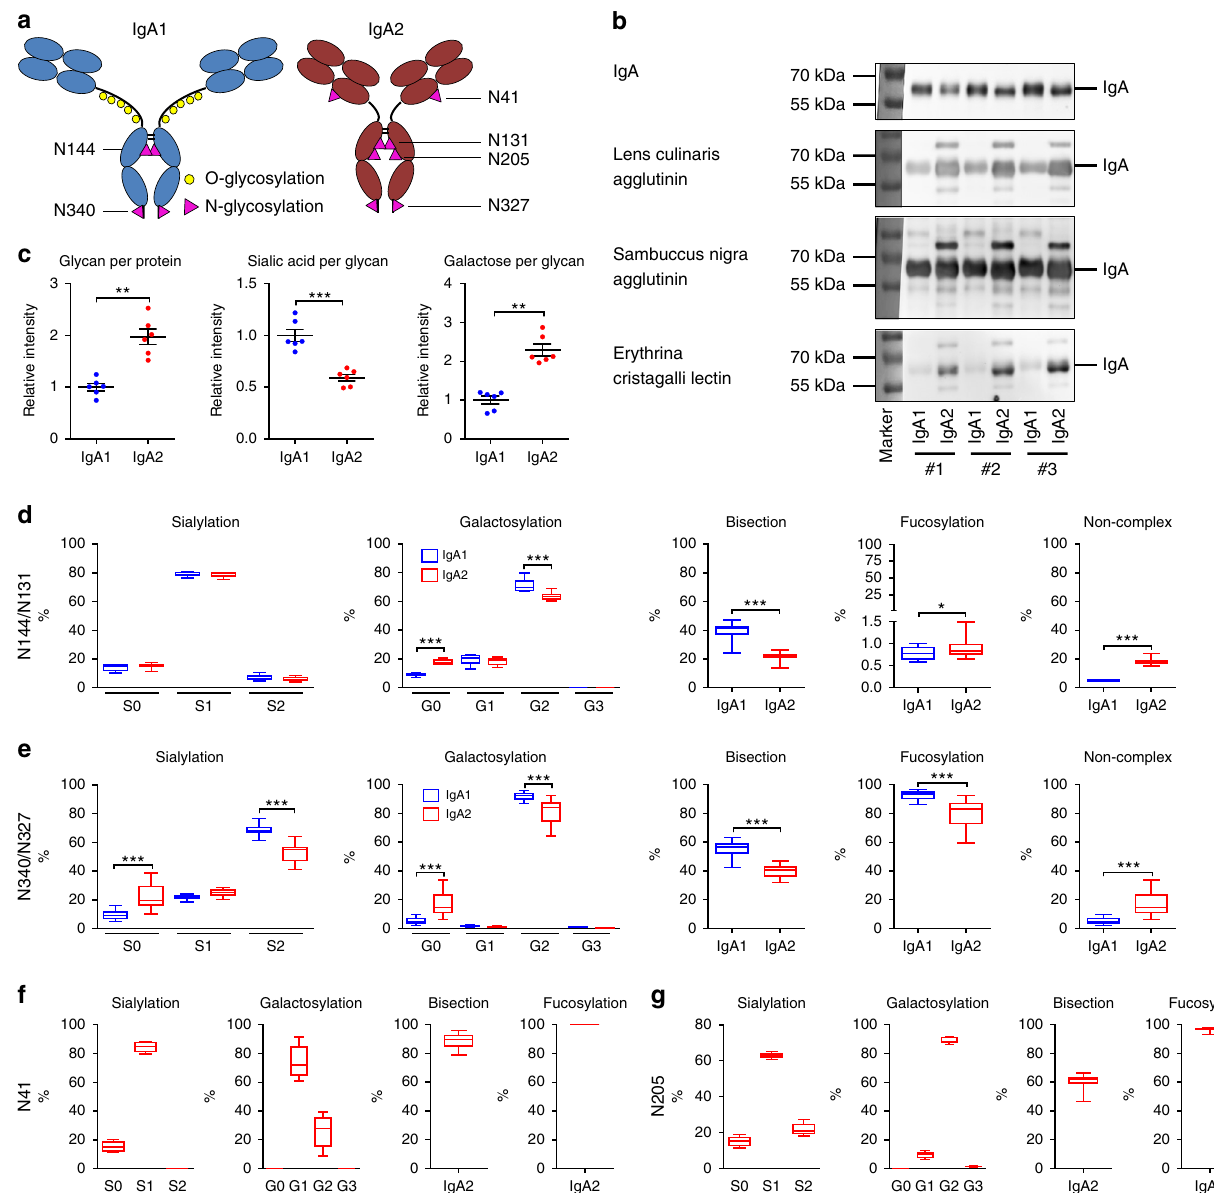
Fig. 3 IgA1 and IgA2 are differentially glycosylated. a Schematic overview of glycosylation sites in IgA1 and IgA2. Bold letters indicate glycosylation sites present in both IgA subclasses. b Representative lectin blots of IgA1 and IgA2 isolated from sera of healthy donors using antibodies against IgA or lectins against the core structure of N -glycans ( = lens culinaris agglutinin), terminal α 2,6-linked sialic acid ( = sambuccus nigra agglutinin), and terminal galactose ( = erythrina christagalli lectin). c Quanti fi cation of the lectin blots; n = 6 donors. d – f Mass spectrometric quanti fi cation of sialyation, galactosylation, bisection, fucosylation, and the presence of noncomplex structures for the glycosylation sites N144/N131 d , N340/N327 e , N41 f , and N205 g ; n = 12 donors. Signi fi cances were tested with paired two-sided Student ’ s t -test c – g or paired one-way ANOVA followed by Bonferroni correction for selected pairs of columns d – g . * p < 0,05; ** p < 0,01; and *** p < 0,001. Data are presented as scatter plots with mean ± s.e.m. c or box plots with medians and inter- quartile ranges + whiskers ranging from min to max d – g . Source data are provided as a Source Data fi